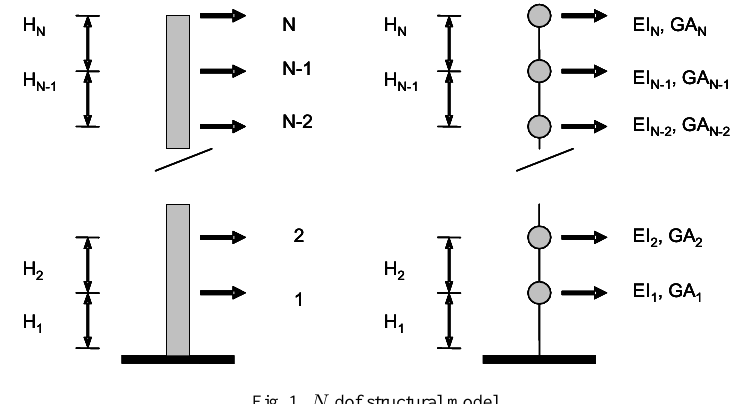
Fig. 1. N dof structural